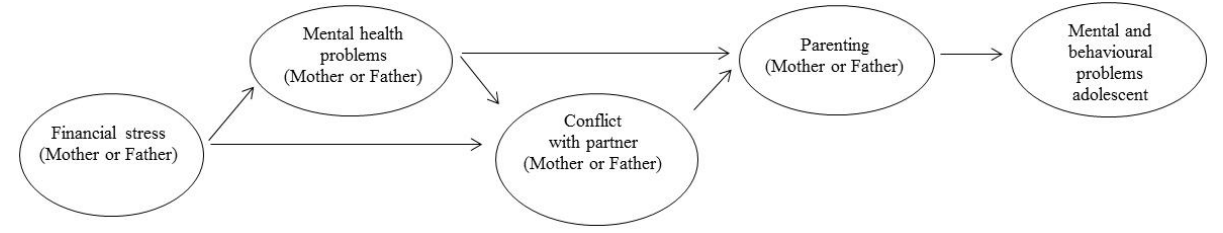
Figure 2. An individual approach of the family stress